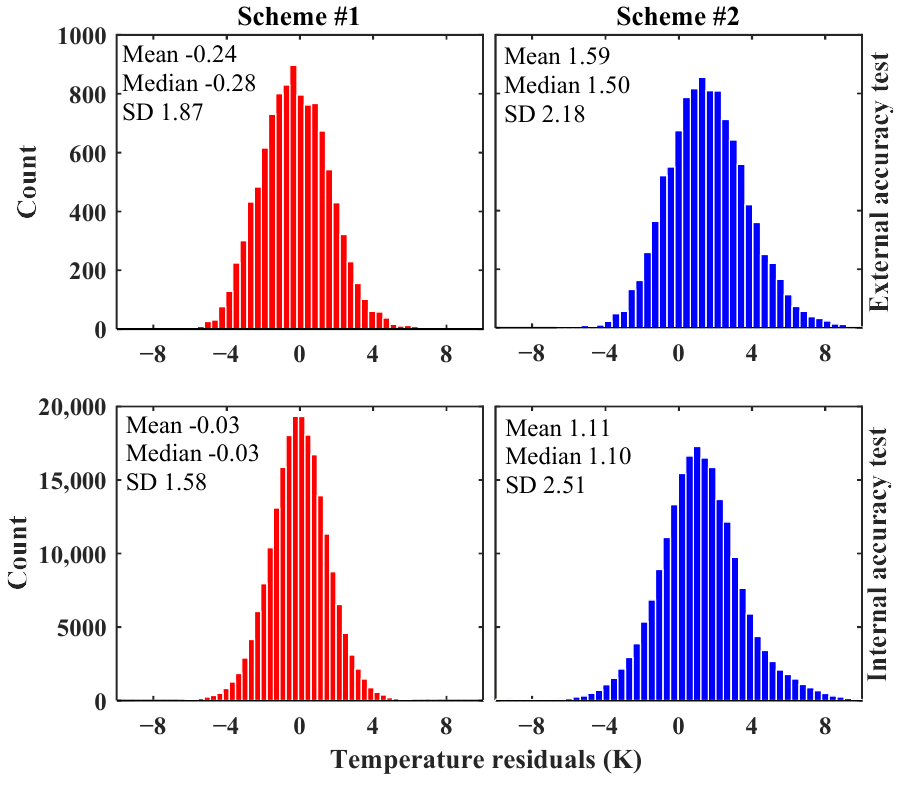
Figure 7. Histogram of the temperature residuals for the two schemes in the internal and external accuracy tests.